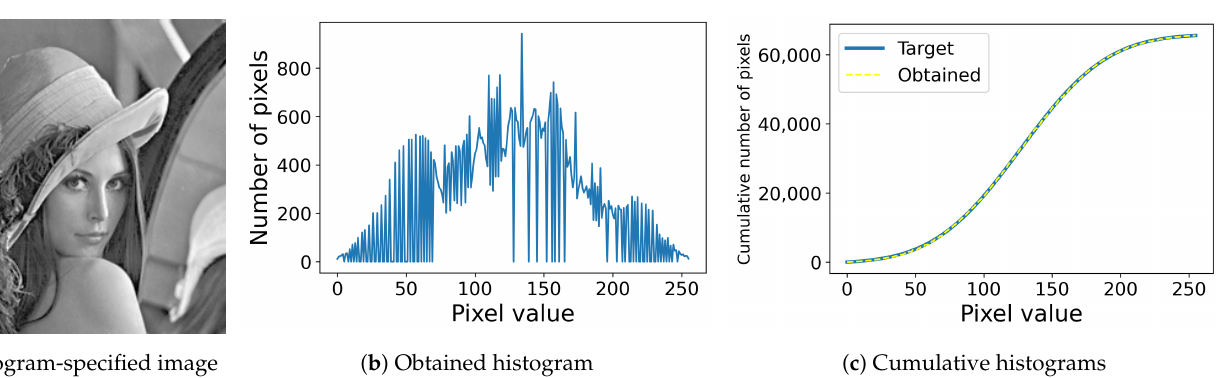
Figure 2. Histogram specification: ( a ) histogram-specified image computed from the original image in Figure 1a with a Gaussian target histogram; ( b ) the histogram of the image ( a ); ( c ) the target (blue solid line) and obtained (yellow dashed line) cumulative